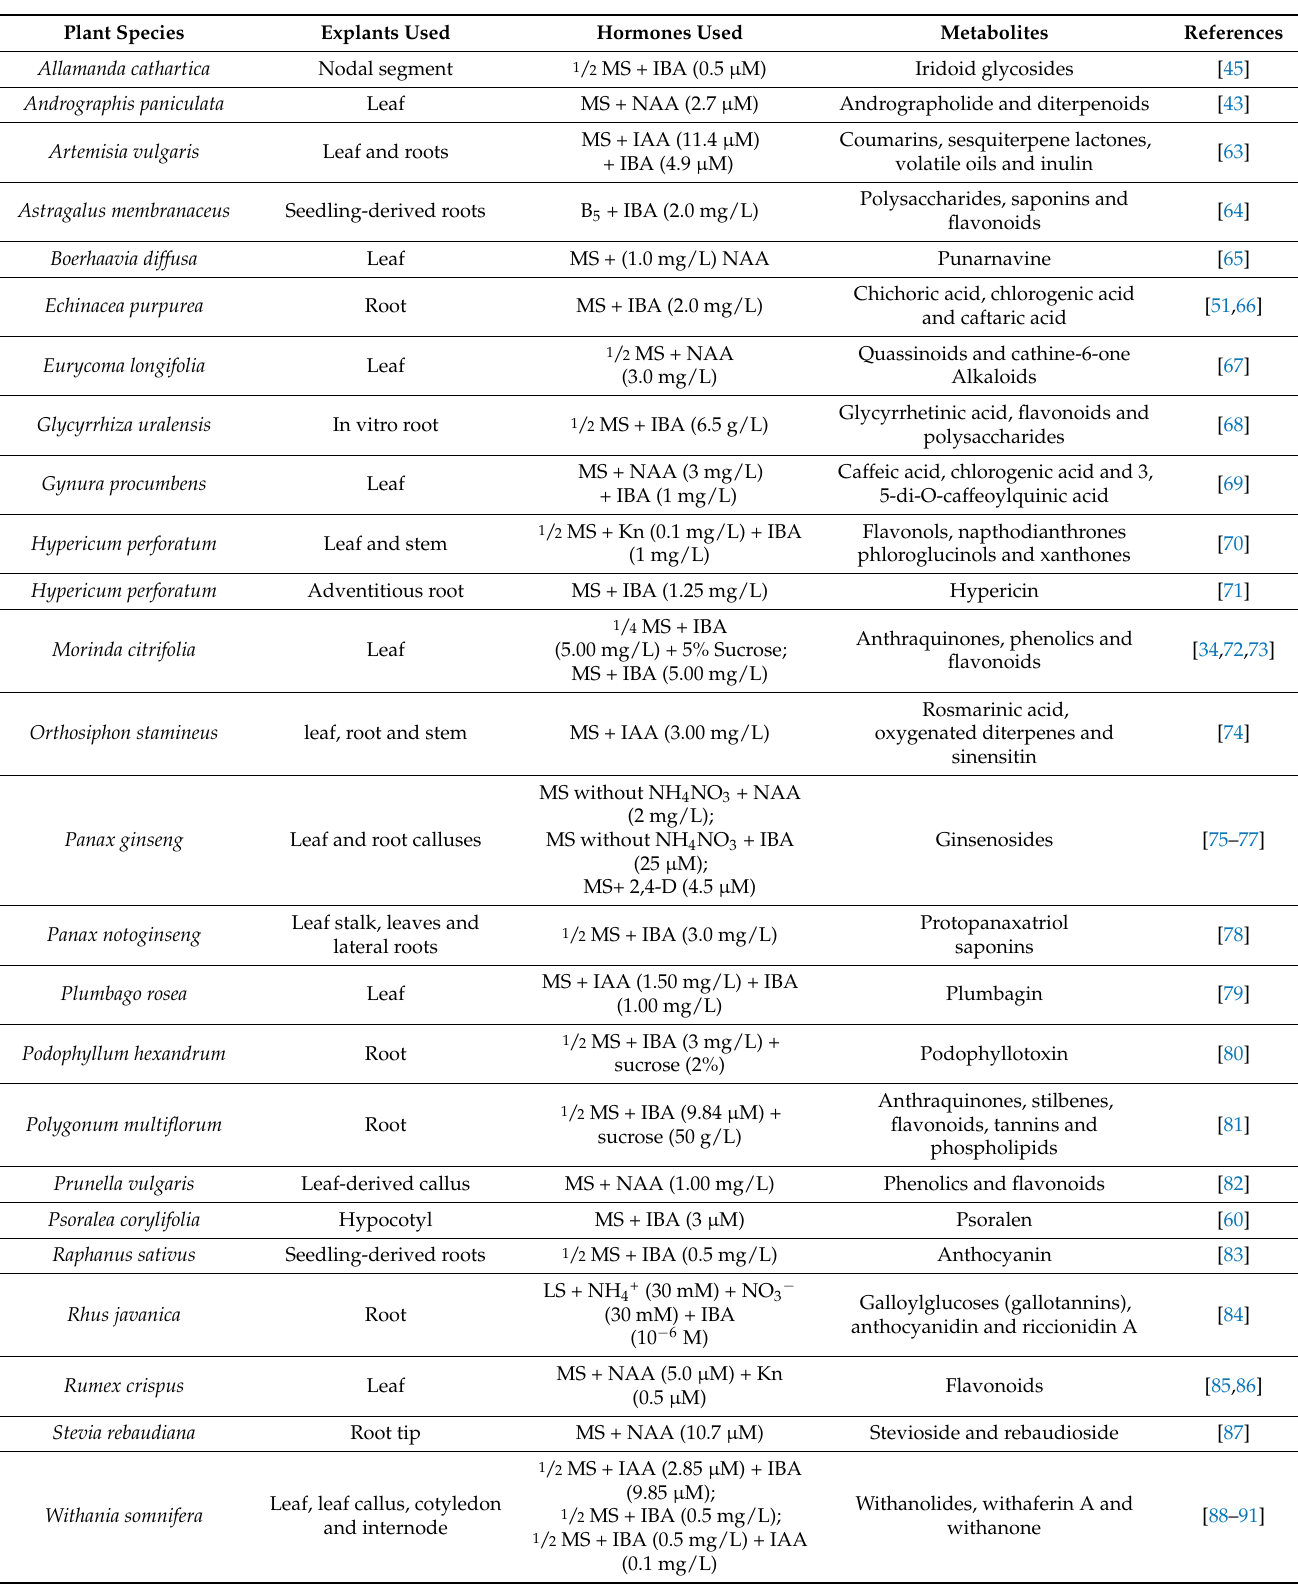
Table 1. Role of PGRs in secondary metabolite production in various